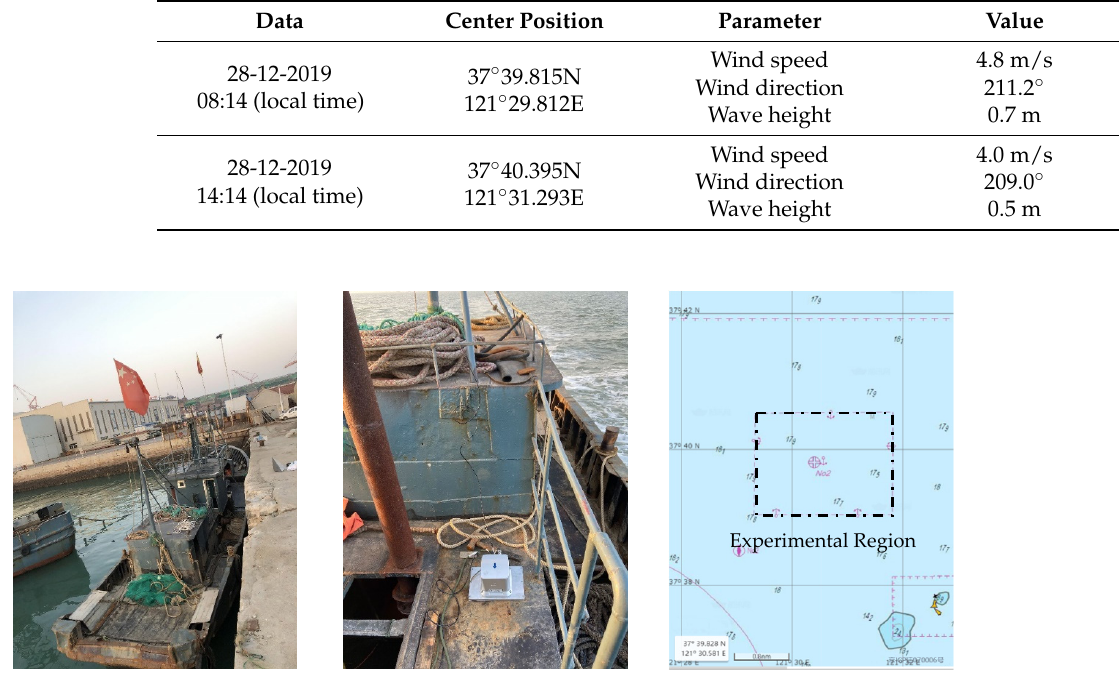
Table 6. Summary of the sea states during data acquisition.